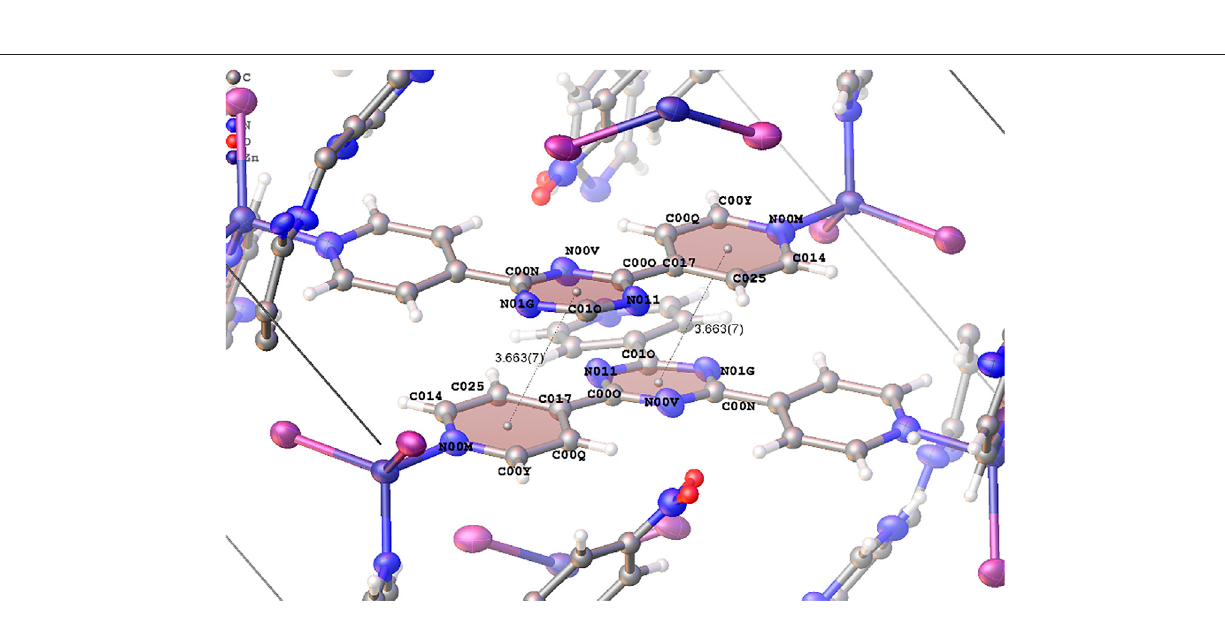
FIGURE 4 | π – π interaction between pyridyl and triazine ring in different complex